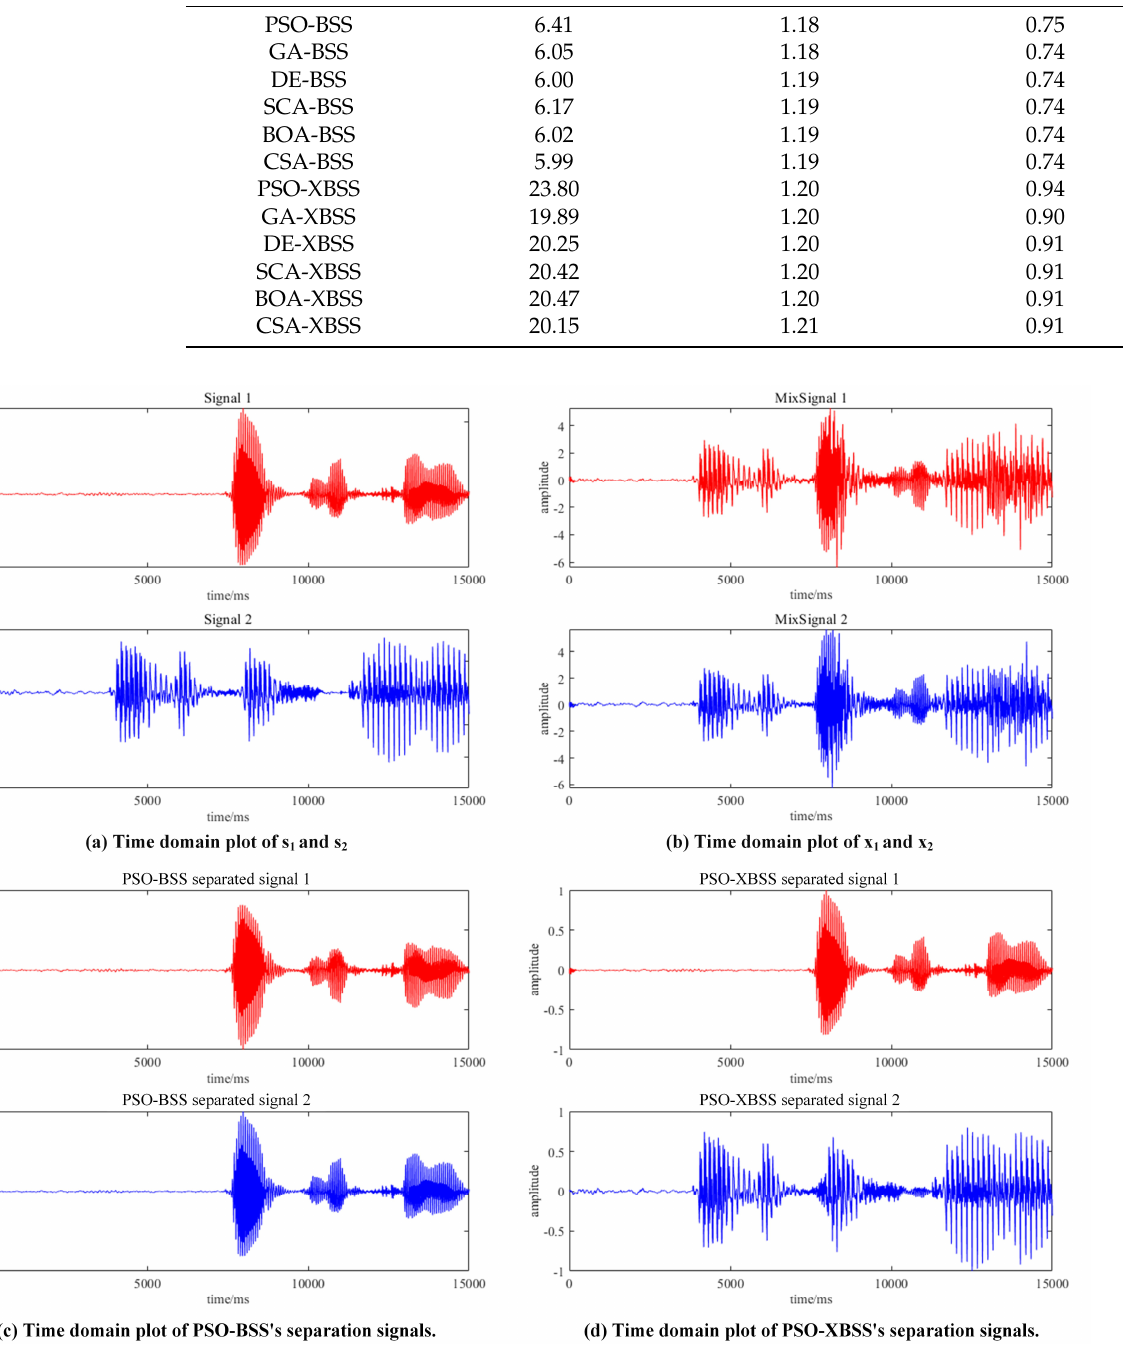
Figure 8. The time domain diagrams of source signals, mixed signals, and separated signals of PSO-BSS and PSO-XBSS. ( s 1 represents the first source signal, and s 2 represents the other source signal. x 1 represents the first mixed signal, and x 2 represents the other mixed